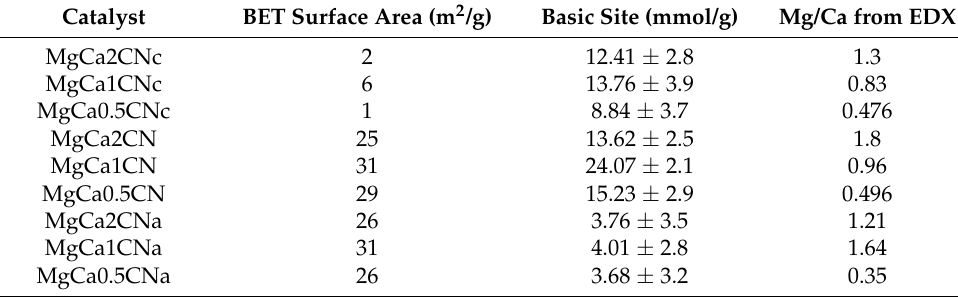
Table 1. BET surface areas, EDX, and basic sites of the catalysts.